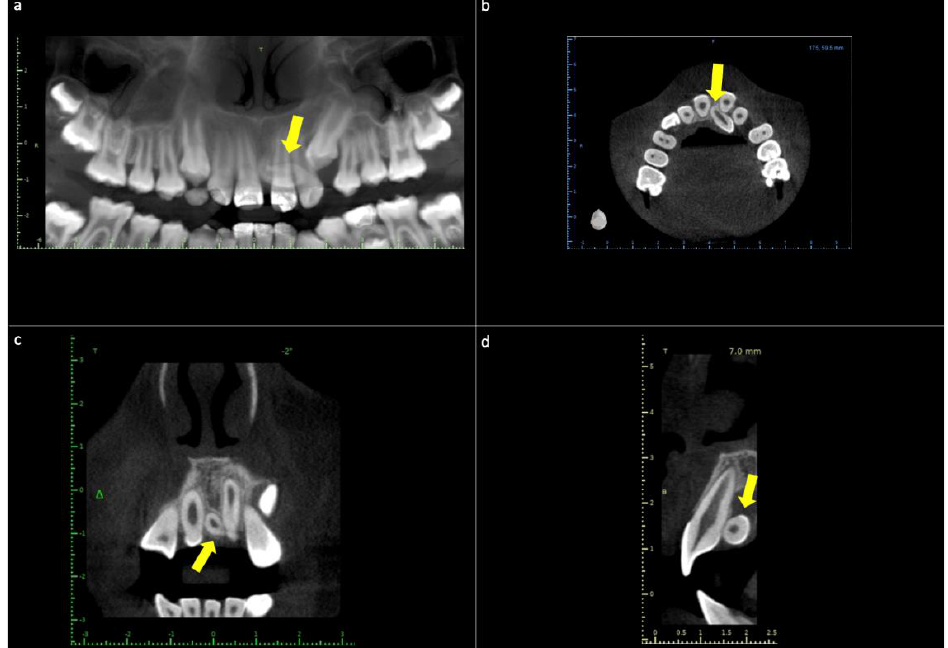
Figure 1. Cone − beam computed tomography (CBCT) of the maxilla. ( a ) The panoramic reconstruc- tion shows the presence of a mesiodens supernumerary tooth between the midlines of maxillary central teeth. ( b ) Axial slice image showing the palatal location of the mesiodens in intimate relation to teeth 2.1 and 2.2. ( c ) Frontal slice image showing mesiodens between central incisors. ( d ) Sagittal slice image showing the palatal location of the supernumerary tooth in the crown-apical middle third of the central incisor. Yellow arrows — location of mesiodens